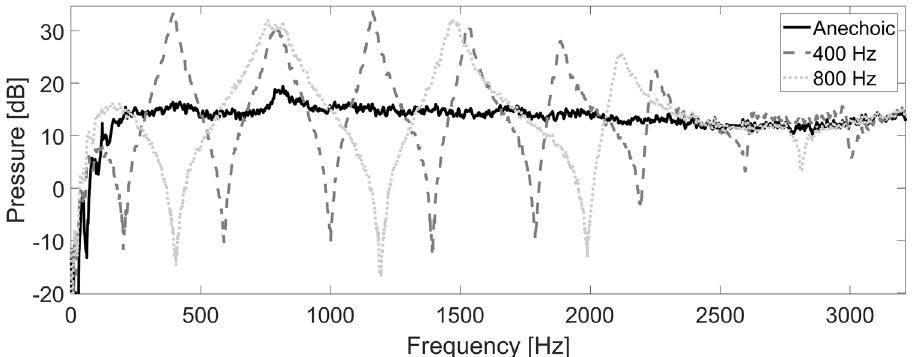
Figure 1. Frequency responses of the anechoic subglottal tract and of the resonant subglottal tract with the piston set to two different positions corresponding to f R1 = 400 and 800 Hz. Whereas the resonant tracts show multiple resonances and antiresonances (as expected for a tube with closed ends), the anechoic tract is practically free of